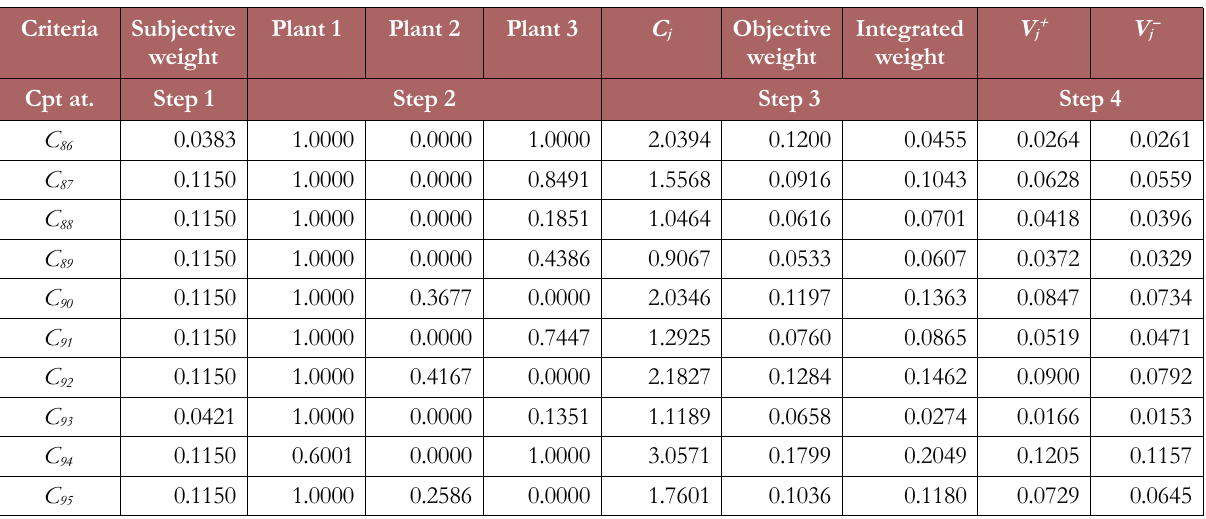
Table 19. Computation of rough BWM-CRITIC-TOPSIS for autonomous systems